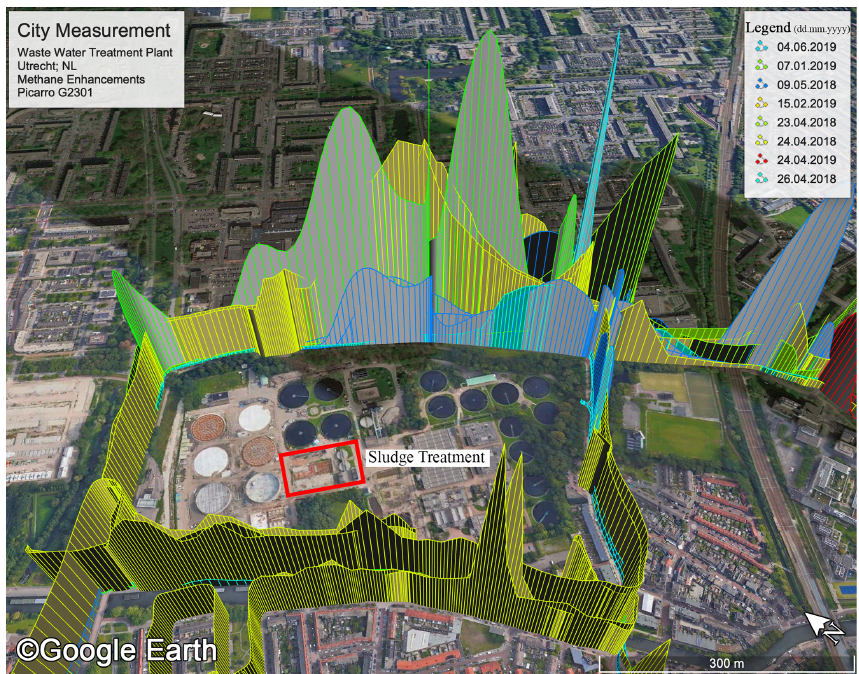
Figure 6. CH 4 enhancements measured downwind of the waste water treatment plant on Brailledreef Street and later used for quantifications from this facility in Utrecht; the center of the area where the sludge treatment is located was considered the effective CH 4 emission source. The plumes are plotted on the same scale, and maximum CH 4 enhancement is ≈ 0 .